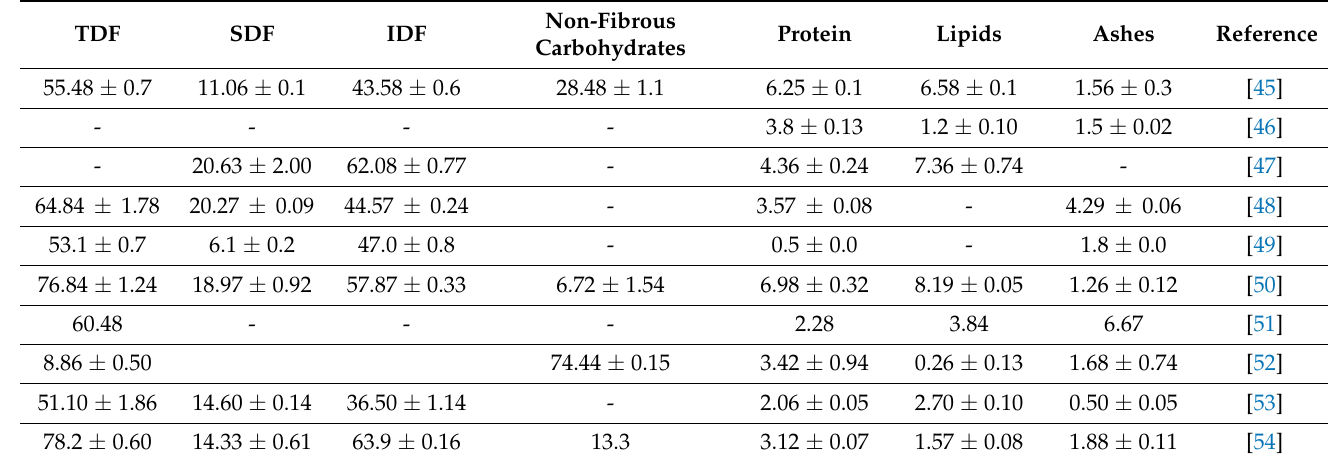
Table 1. Proximate composition of apple pomace in dry matter (%).